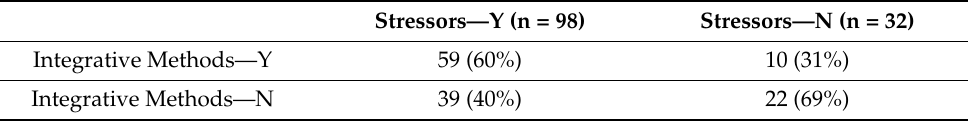
Table 3. Correlation between Presence of Stressors and Usage of Integrative Modalities .